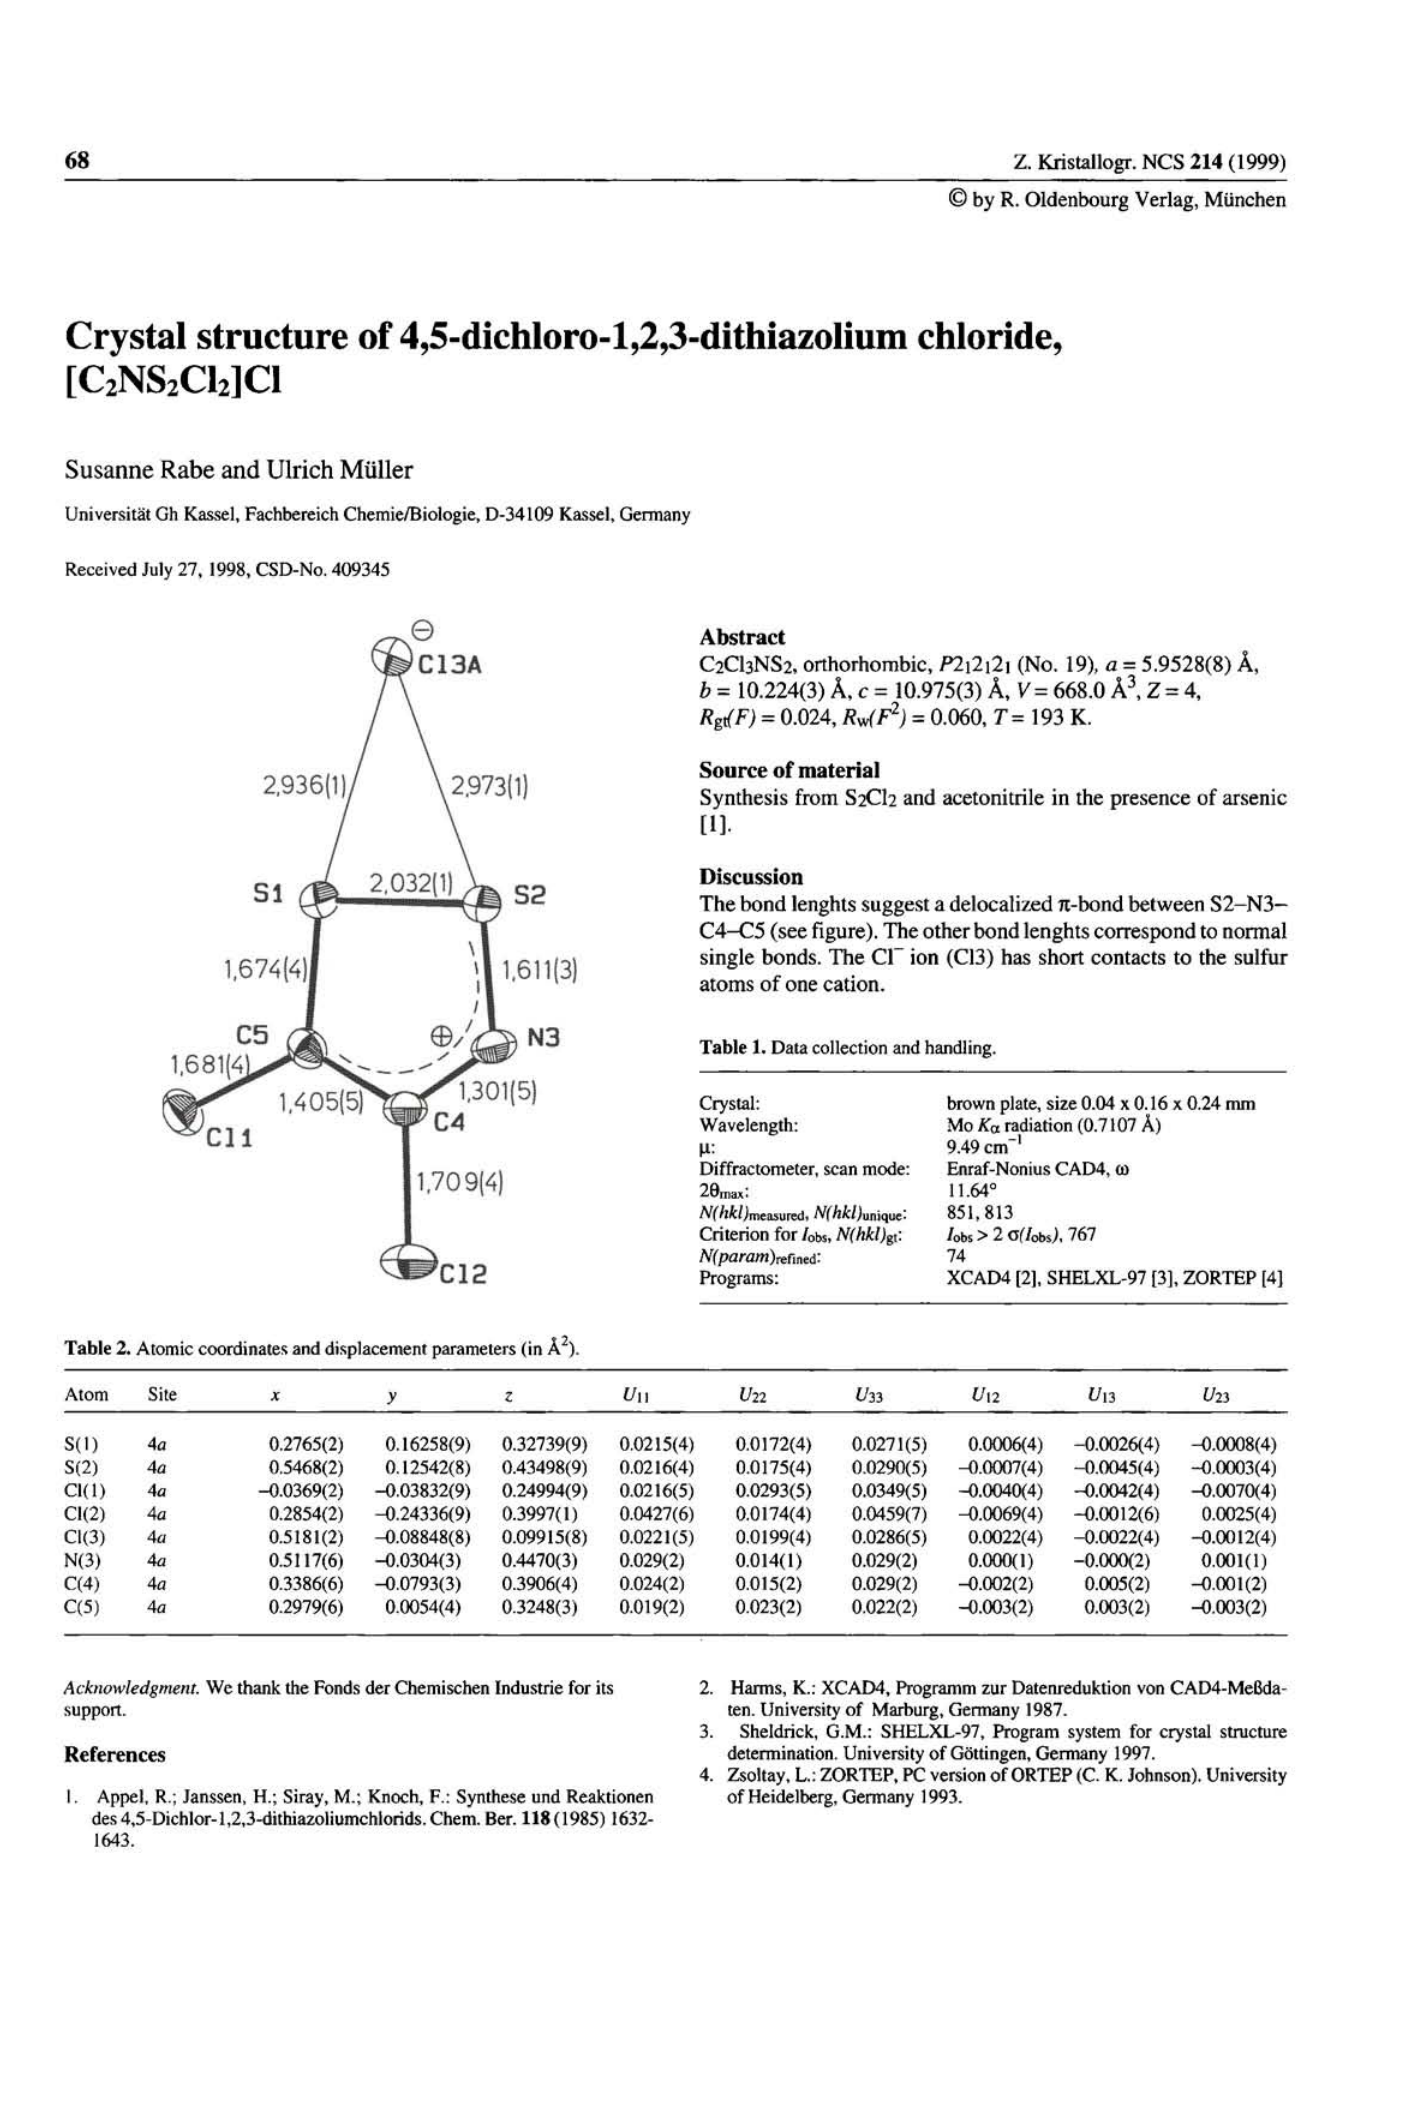
Table 1. Data collection and handling.